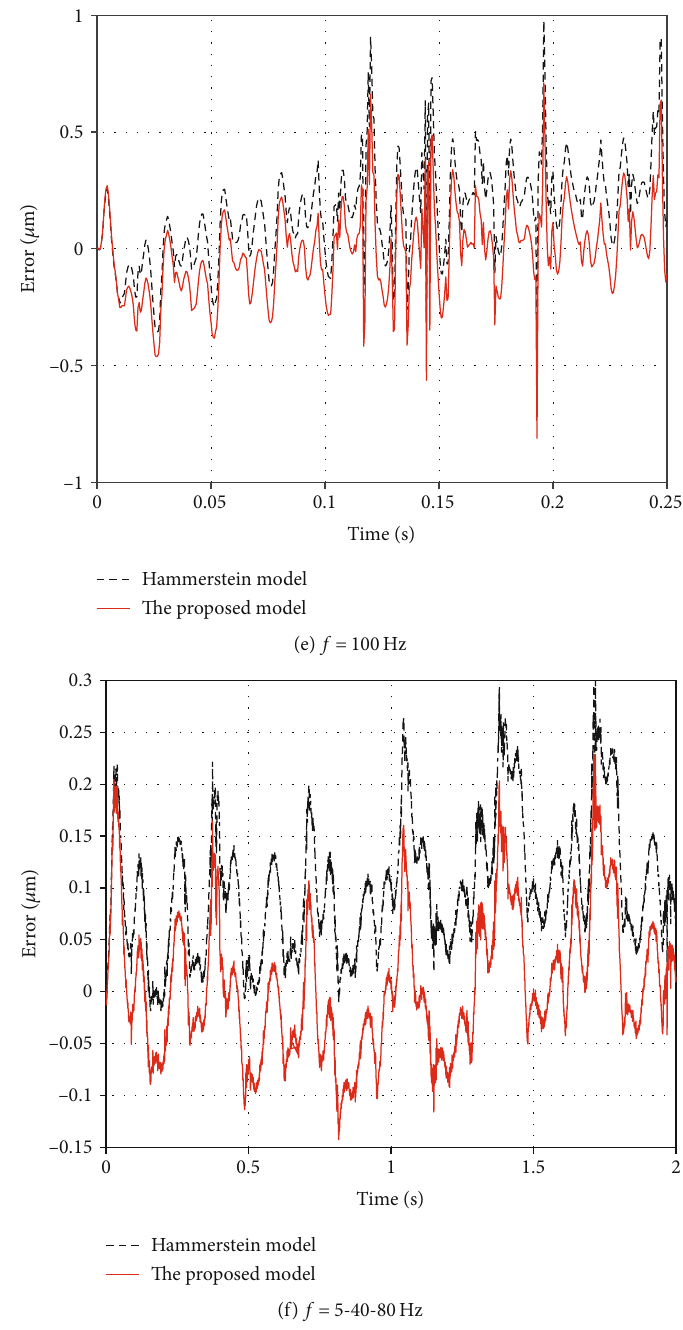
Figure 5: Error analysis of Hammerstein model and the proposed the entire experimental system is as follows. The signal gen- Figure 3. The main parts of the entire experimental system erator inputs a voltage signal of 0-10 V; after the power are the following. (a) Experimental piezoelectric stage ampli fi er, the input voltage range becomes a voltage signal PS1H80-030U, (b) piezo driver PH301, (c) signal generator of 0-150 V and a bandwidth of 6 kHz, which is input to the SAB101, and (d) display and interface panel and experimen- piezoelectric driver through the display and interface panel tal computer as a controller. The piezoelectric-actuated posi- as the driving voltage of the positioning stage, the output tioning stage includes a mobile stage, a piezoelectric actuator, displacement of the positioning stage is measured by the and a displacement sensor. The resolution of the displace- displacement sensor, and the output displacement range is ment sensor is 2 nm, and the maximum displacement dis- 0-100 μ m after being ampli fi ed by the fl exible hinge. The tance of the mobile stage is 30 μ m. The working process of